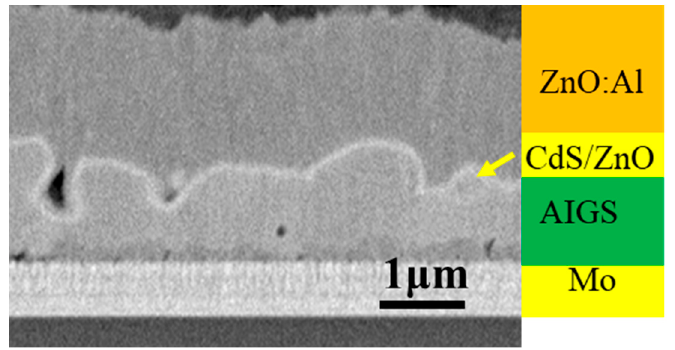
Figure 8. Cross-sectional SEM image of a typical AIGS solar cell.